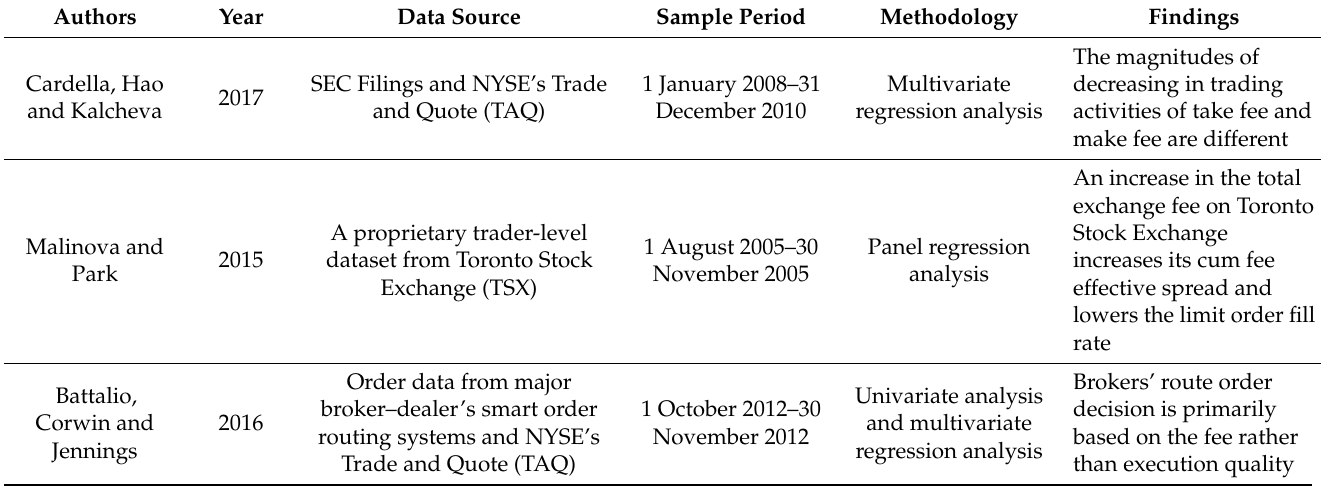
Table A1. Summary of market microstructure empirical studies on order routing